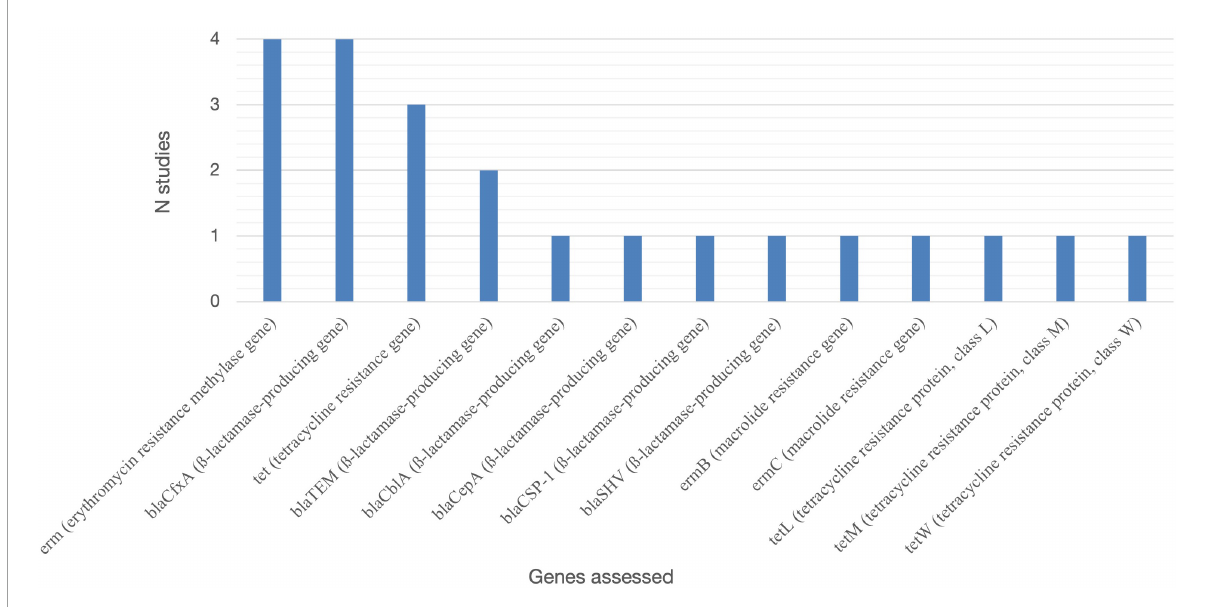
FIGURE3 Resistance genes assessed in the included studies. erm, erythromycin resistance methylase gene; blaCfxA, ß-lactamase-producing gene; tet, tetracycline resistance gene; blaTEM, ß-lactamase-producing gene; blaCblA, ß-lactamase-producing gene; blaCepA, ß-lactamase-producing gene; blaCSP-1, ß-lactamase-producing gene; blaSHV, ß-lactamase-producing gene; ermB, macrolide resistance gene; ermC, macrolide resistance gene; tetL, tetracycline resistance protein, class L; tetM, tetracycline resistance protein, class M; tetW, tetracycline resistance protein, class